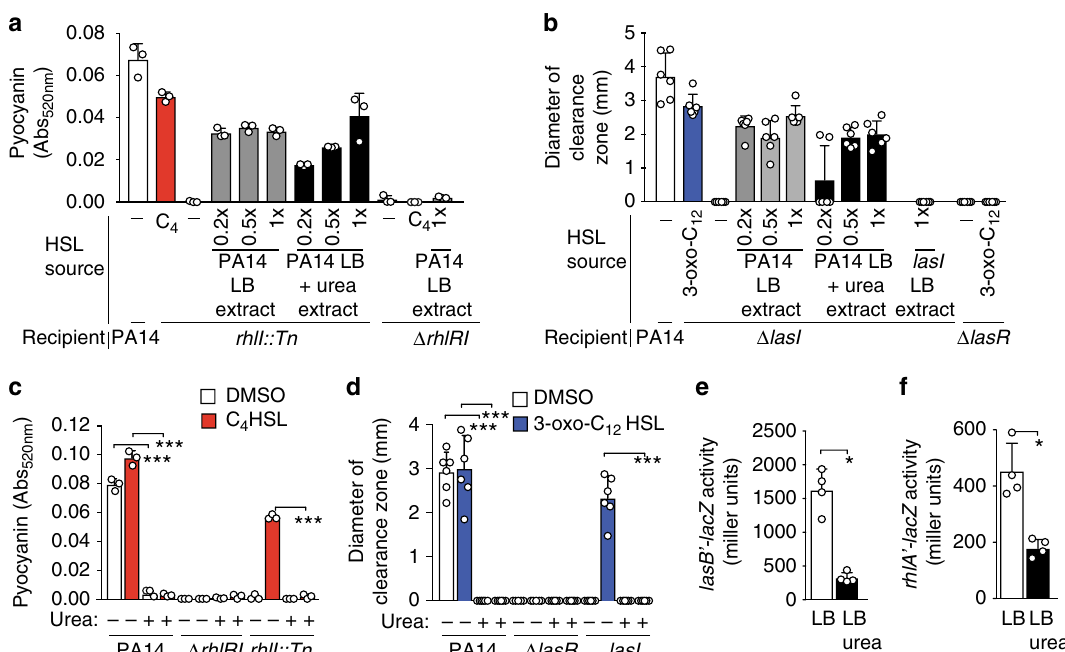
Fig. 3 Urea affects perception, but not production, of autoinducers. a Production of C 4 -HSL by P. aeruginosa grown in the presence and absence of urea was assessed by the ability of spent media extracts to promote production of pyocyanin by PA14, rhlI::Tn , and Δ rhlRI . b Production of 3-oxo-C 12 -HSL by P. aeruginosa grown in the presence and absence of urea was quanti fi ed by the ability of spent media extracts to promote protease activity by PA14, Δ lasI , and Δ lasR grown on milk plates. Extracts of culture supernatants from cells grown in the absence of urea (gray) and presence of urea (black) are indicated. c Perception of chemically synthesized C 4 -HSL (0.5 µ M) as measured by pyocyanin production by PA14, rhlI::Tn , Δ rhlRI grown in LB in the absence and presence of 0.5 M urea. d Perception of chemically synthesized 3-oxo-C 12 -HSL (1 µ M) as quanti fi ed by PA14, Δ lasI, and Δ lasR grown on milk plates in the absence or presence of 0.5 M urea. Samples, in which control HSL was added, are indicated in red for C 4 -HSL and blue for 3-oxo-C 12 -HSL. e , f Beta-gal activity was measured for E. coli strain DH5 α carrying either e pECP64 (ptac- lasR, lasB ′ -lacZ ) or f pECP61 (ptac- rhlR rhlA ’ -lacZ ) grown with 5 nM 3-oxo-C 12 - HSL or 5 µ M C 4 -HSL, respectively, in the presence (solid) or absence (open) of 0.5 M urea. Data represent the mean and standard deviation of at least three independent samples for each incubation time. Data were analyzed by unpaired t -test using GraphPad Prism software. Asterisk (*, **, and ***) indicates p < 0.05, <0.01, and <0.001, induce pyocyanin or elastase production in the presence of urea. Plasmid-derived over-expression of rhlR or lasR in the respective null mutants, while able to complement the respective mutations, did not overcome repression of quorum-regulated phenotypes by urea (Supplementary Figure 1). Since quorum regulation in P.